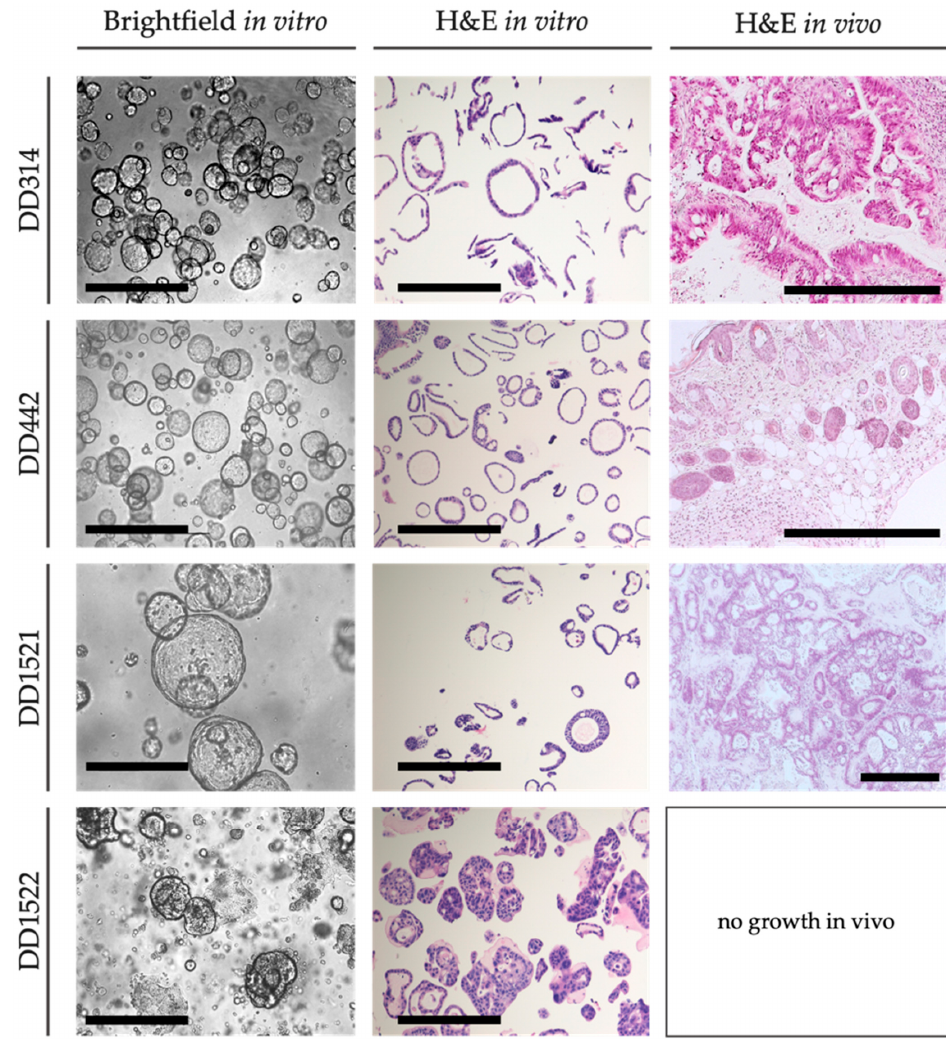
Figure 1. Preservation of PDAC characteristics in vitro and in vivo. Representative brightfield images show the PDO morphology in vitro. Histological sections demonstrate adenomatous morphology in vitro and in vivo (scale bar: 500 µm).